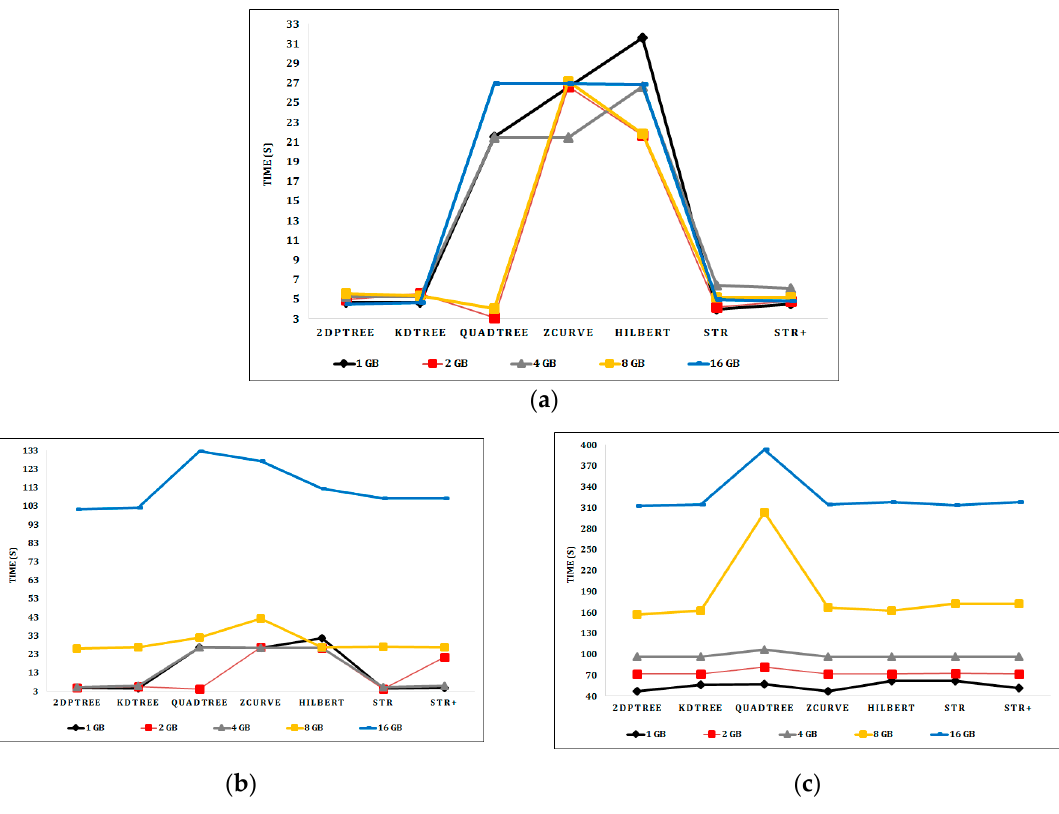
Figure 7. Range query execution time on indexed synthetic datasets: ( a ) Range query with a 0.0001 query window area; ( b ) range query with a 0.01 query window area; ( c ) range query with a query window area equal to the file area.